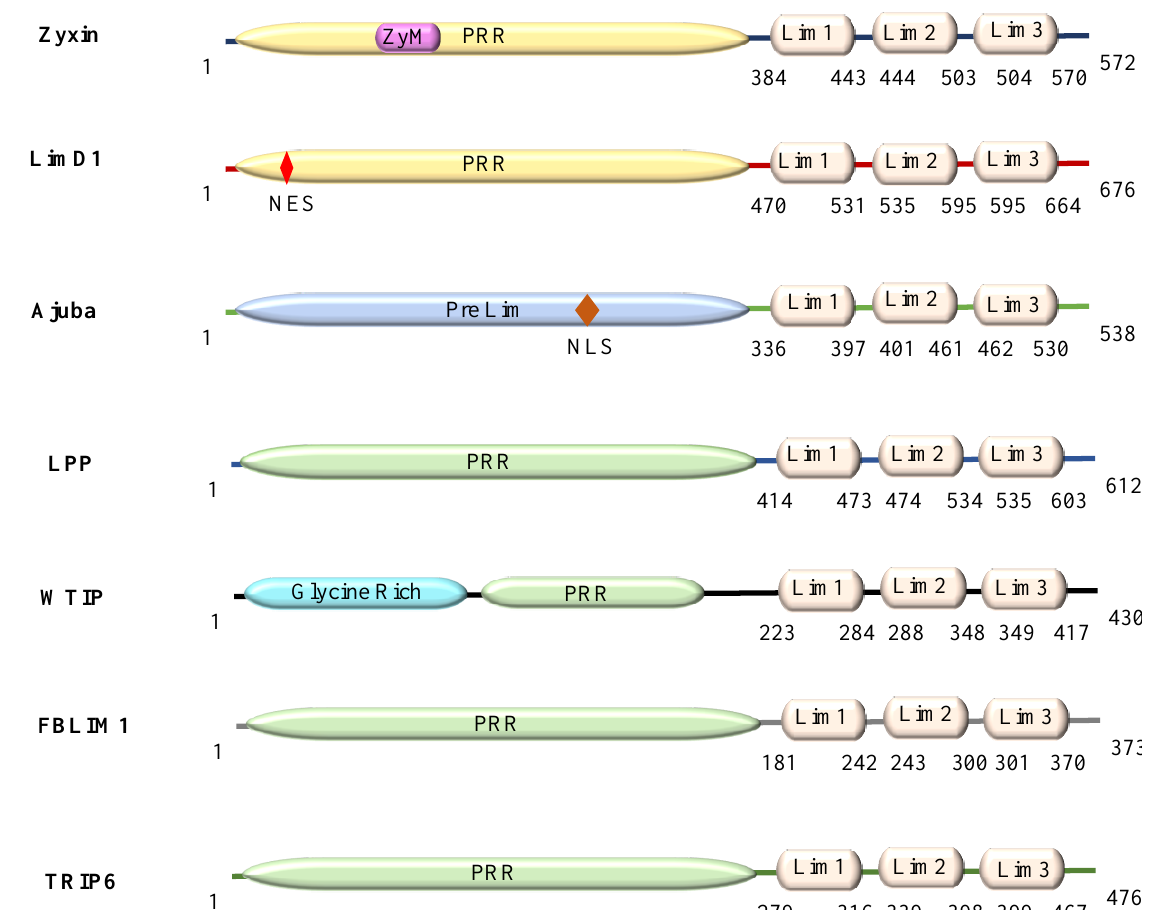
Figure 1. Organization of domains and motifs of Zyxin family proteins: the proline-rich region (PRR) and Lim1/2/3 domains. (NES = Nuclear export sequence, NLS = Nuclear localization Sequence, ZyM = Zyxin motif)